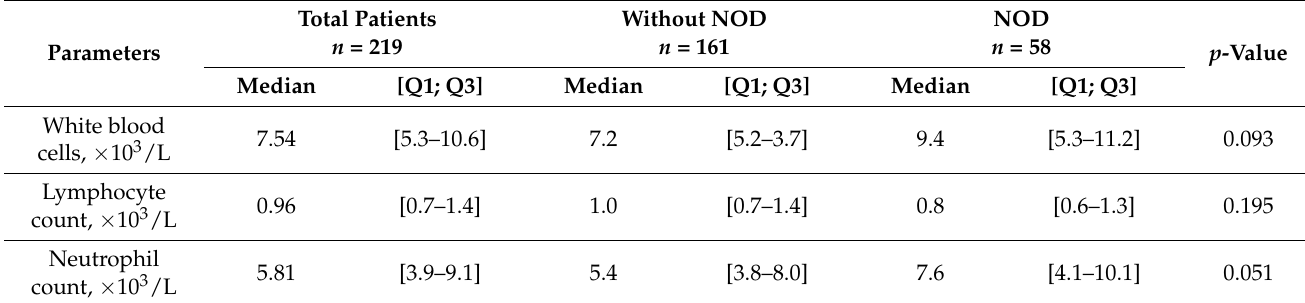
Table 2. Laboratory findings and arterial blood gas at